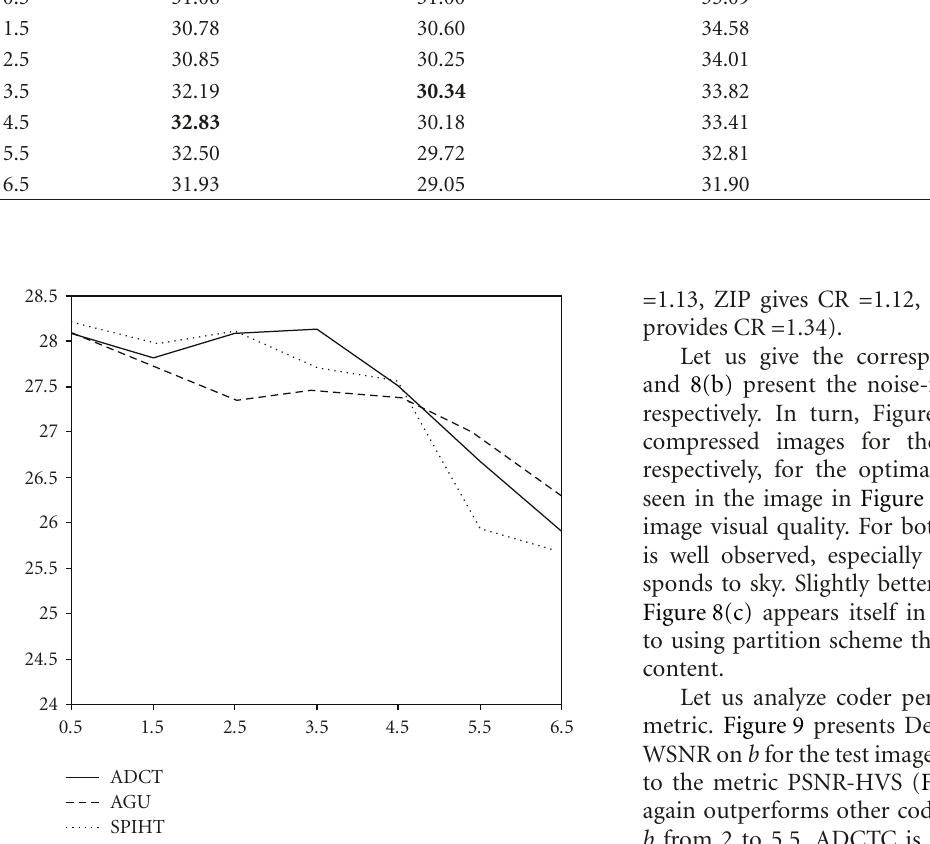
Figure 7: Dependencies of PSNR-HVS on b for di ff erent coders, σ 2 = 100, image